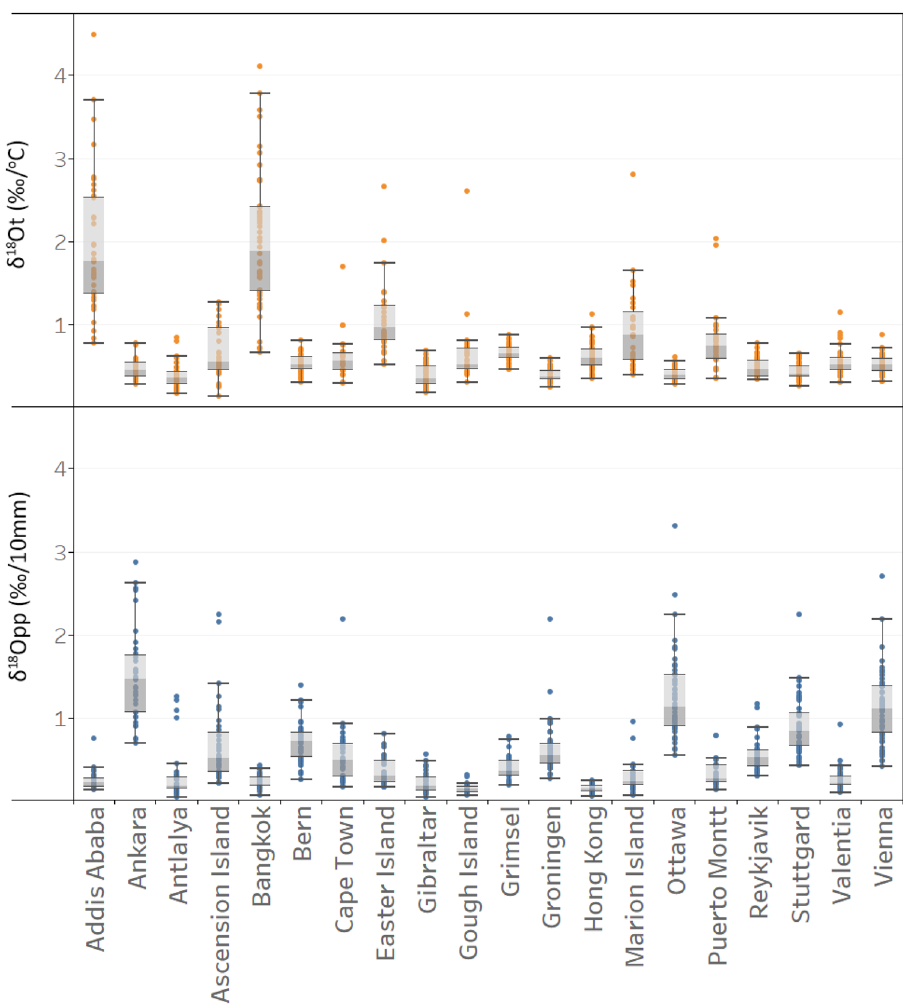
Figure 3. δ 18 O-dependency on T ( δ 18 O t ) and P ( δ 18 O pp ).